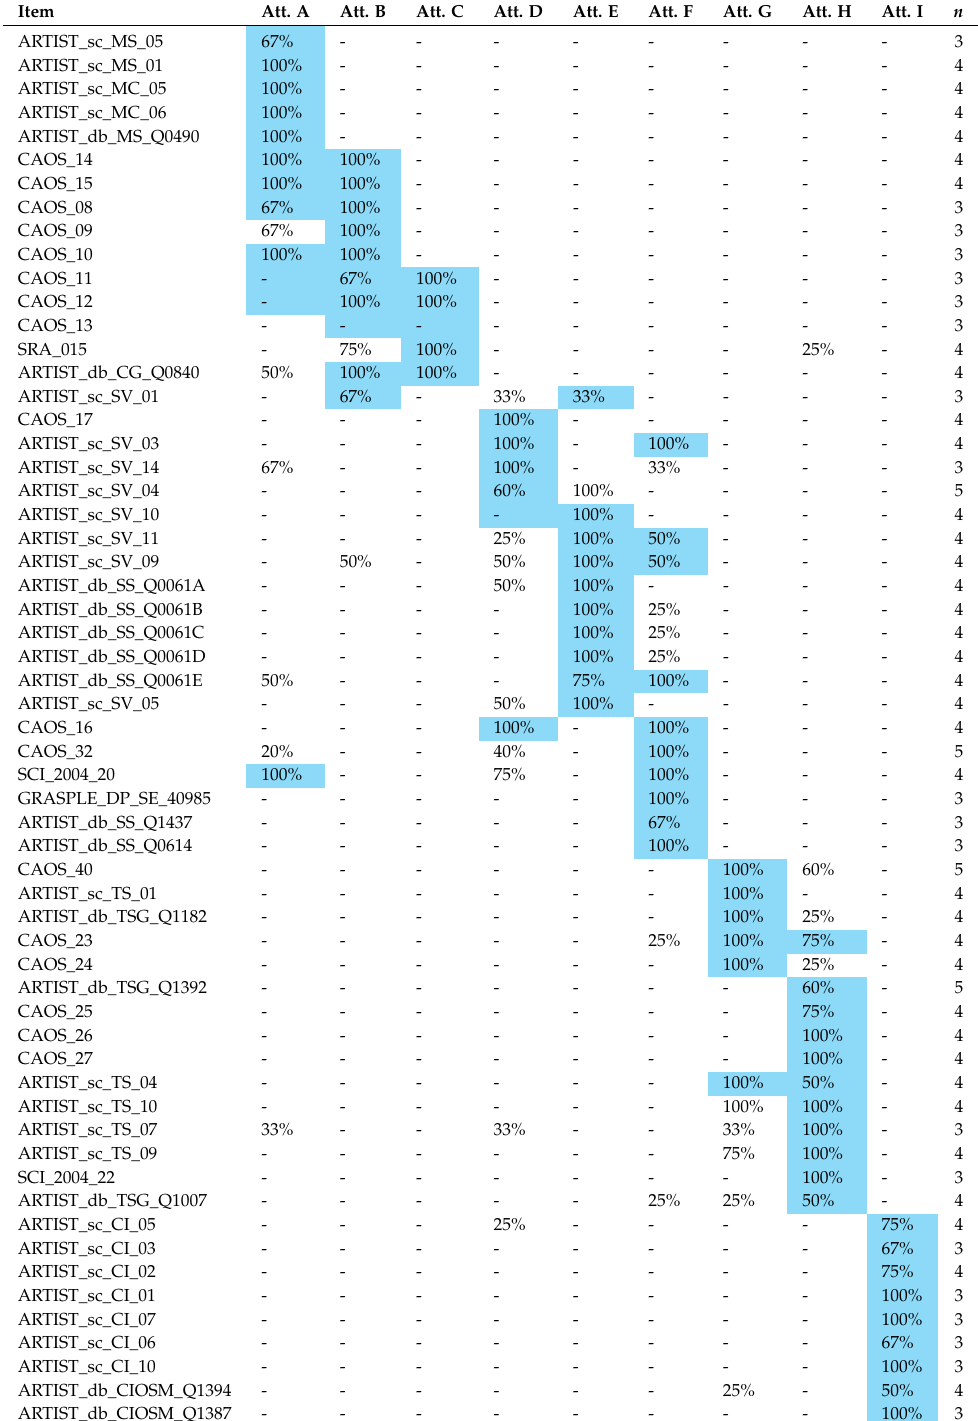
Table 2. Percentages of students using each attribute (Att.) in their reasoning per item (“-” indicates 0%). Colored cells indicate the attributes that are measured by each item according to the provisional Q-matrix. The last column indicates the number of students who answered each item ( n ). Item Att. A Att.